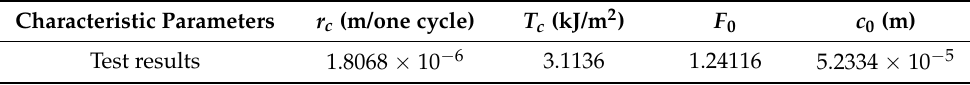
Figure 7. Electromagnetic dynamic fatigue test system. Table 2. Characteristic parameters of fatigue crack propagation of silicone rubber.